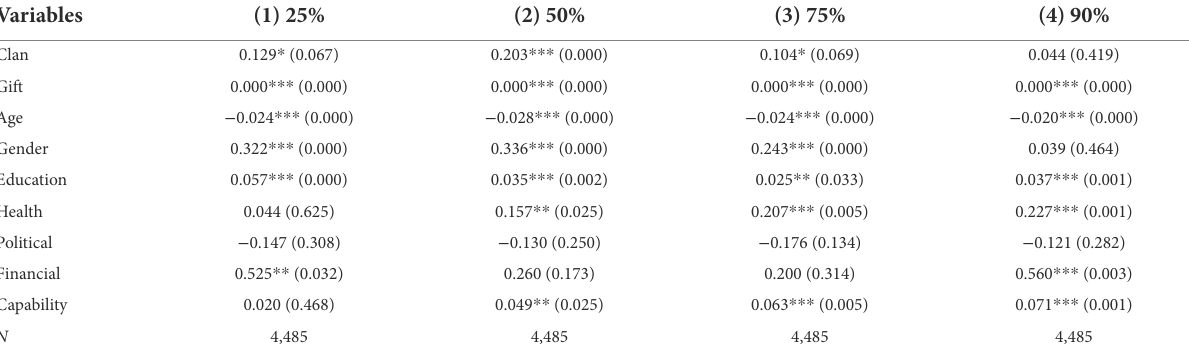
TABLE 7 Quantile regression estimation results for farmers’ entrepreneurial income.